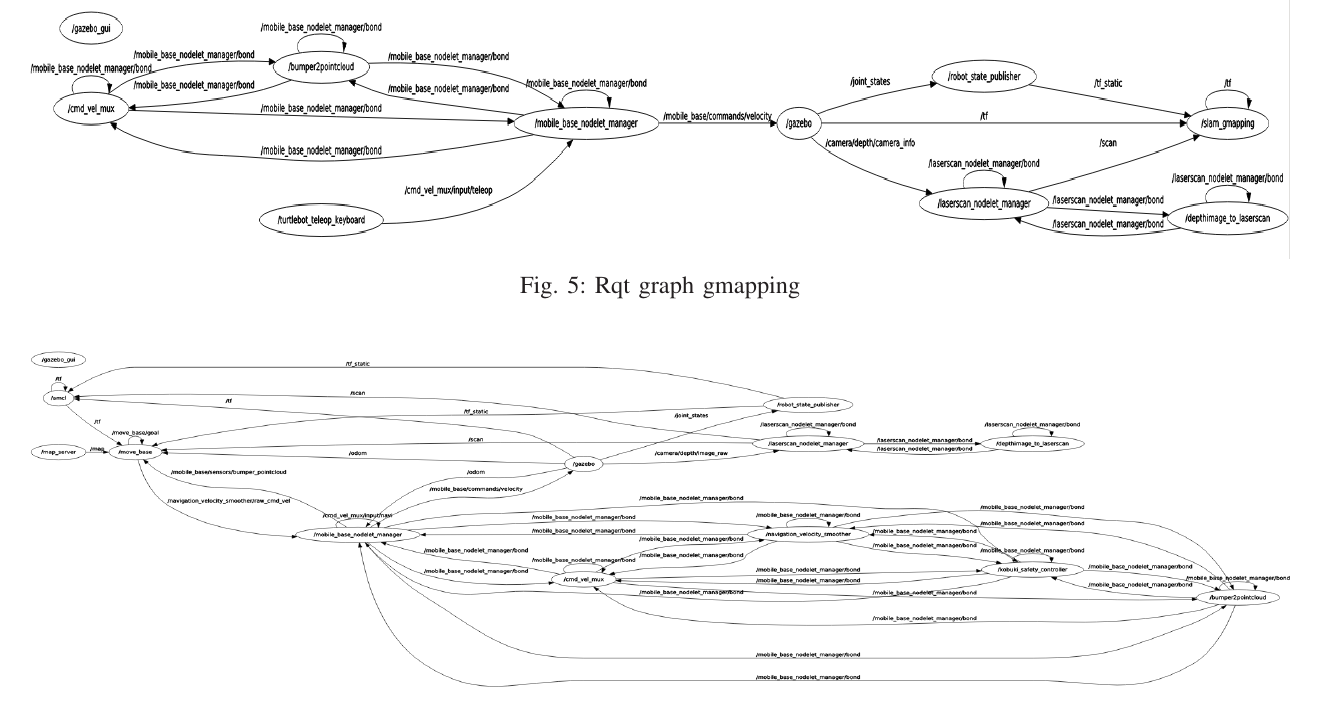
Fig. 6: Rqt graph AMCL